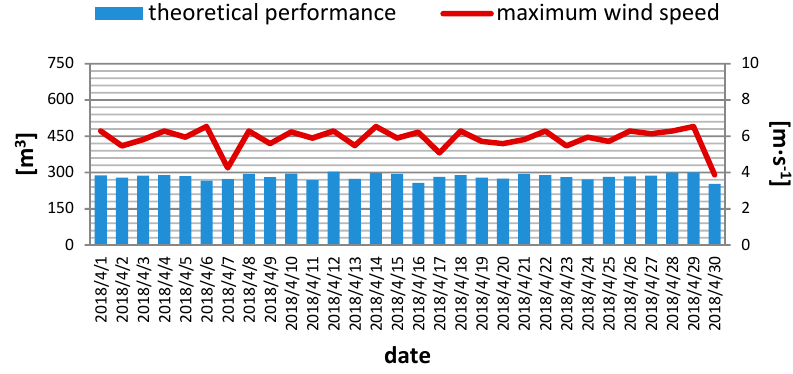
Figure 4. E ffi ciency of the pulverization unit of the aerator in March. Figure 4. Efficiency of the pulverization unit of the aerator in March.